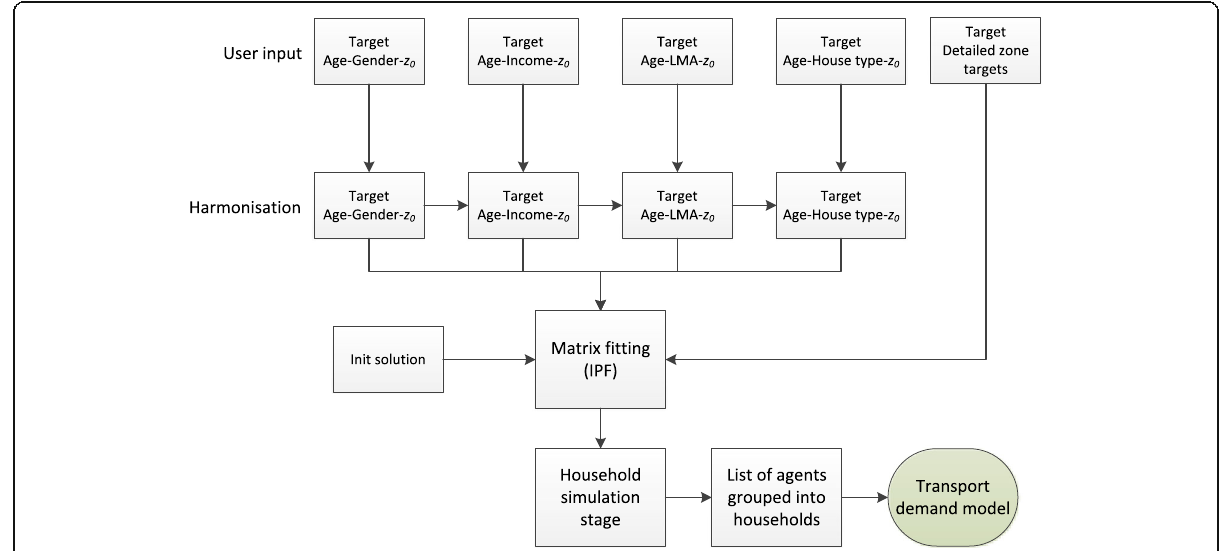
Fig. 2 Overall illustration of the population synthesis structure in The Danish National Transport Model